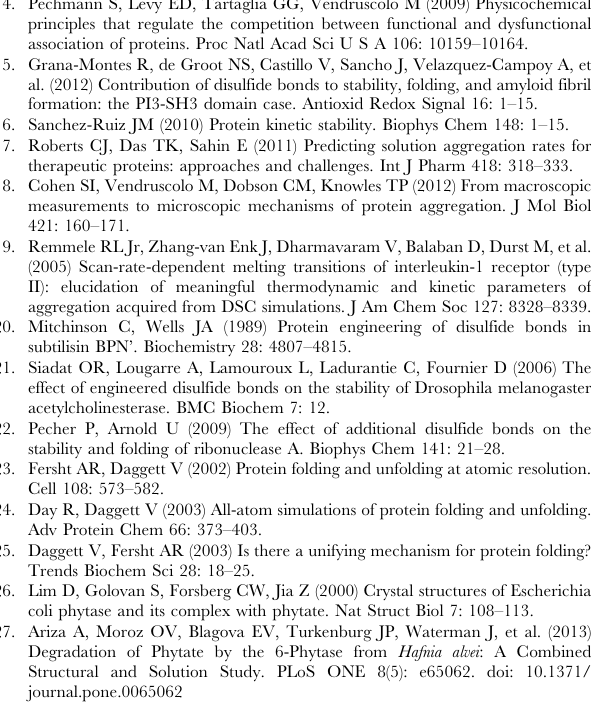
Figure S1 Dynamic light scattering experiments sup- porting aggregation upon irreversible denaturation of phytase. (DOC) Figure S2 Rate constants obtained with total protein concentration of 0.25 and 1 mg/mL. (PDF) Figure S3 Temperature dependence of the time scale ( t 1/2) for the irreversible denaturation of wild type phytase and variants at a protein concentration of 1 mg/ mL. (PDF) Text S1 Experimental section. (DOC) Text S2 Theoretical analysis of a thermal inactivation model involving a critical, lowly-populated intermediate